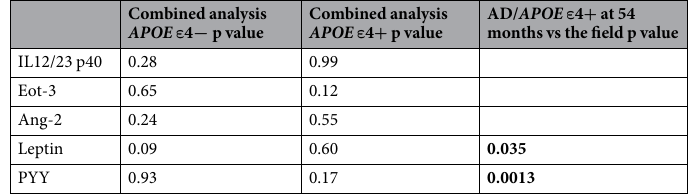
Table 7. Combined analysis of the 5 biomarkers with longitudinal assessment between HC and AD according to the APOE